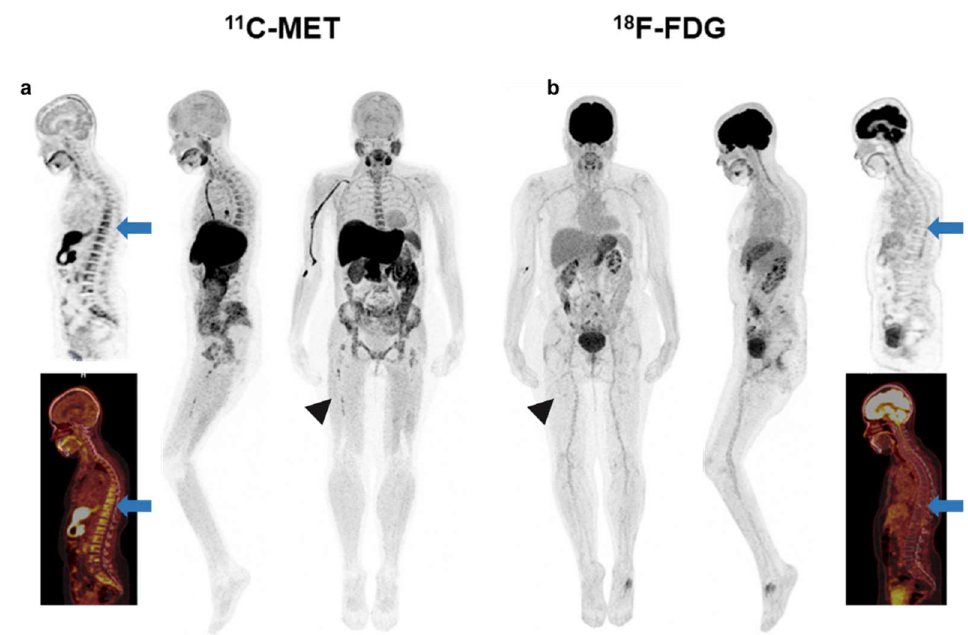
Figure 3. Patient with SMM with diffuse BM uptake (blue arrow-( a )) and FL without lytic component in the left clavicle (red arrow-( b )) in MET PET/CT (SUV max = 1.5). This finding could represent, despite being single, a focal active lesion of multiple myeloma. However, in FDG PET/CT, BM uptake was homogeneous and lower than in the liver (blue arrow-( d )), so inconclusive for malignant infiltration (anaemia?), while no focal uptake was observed in the clavicle (red arrow- ( c )).